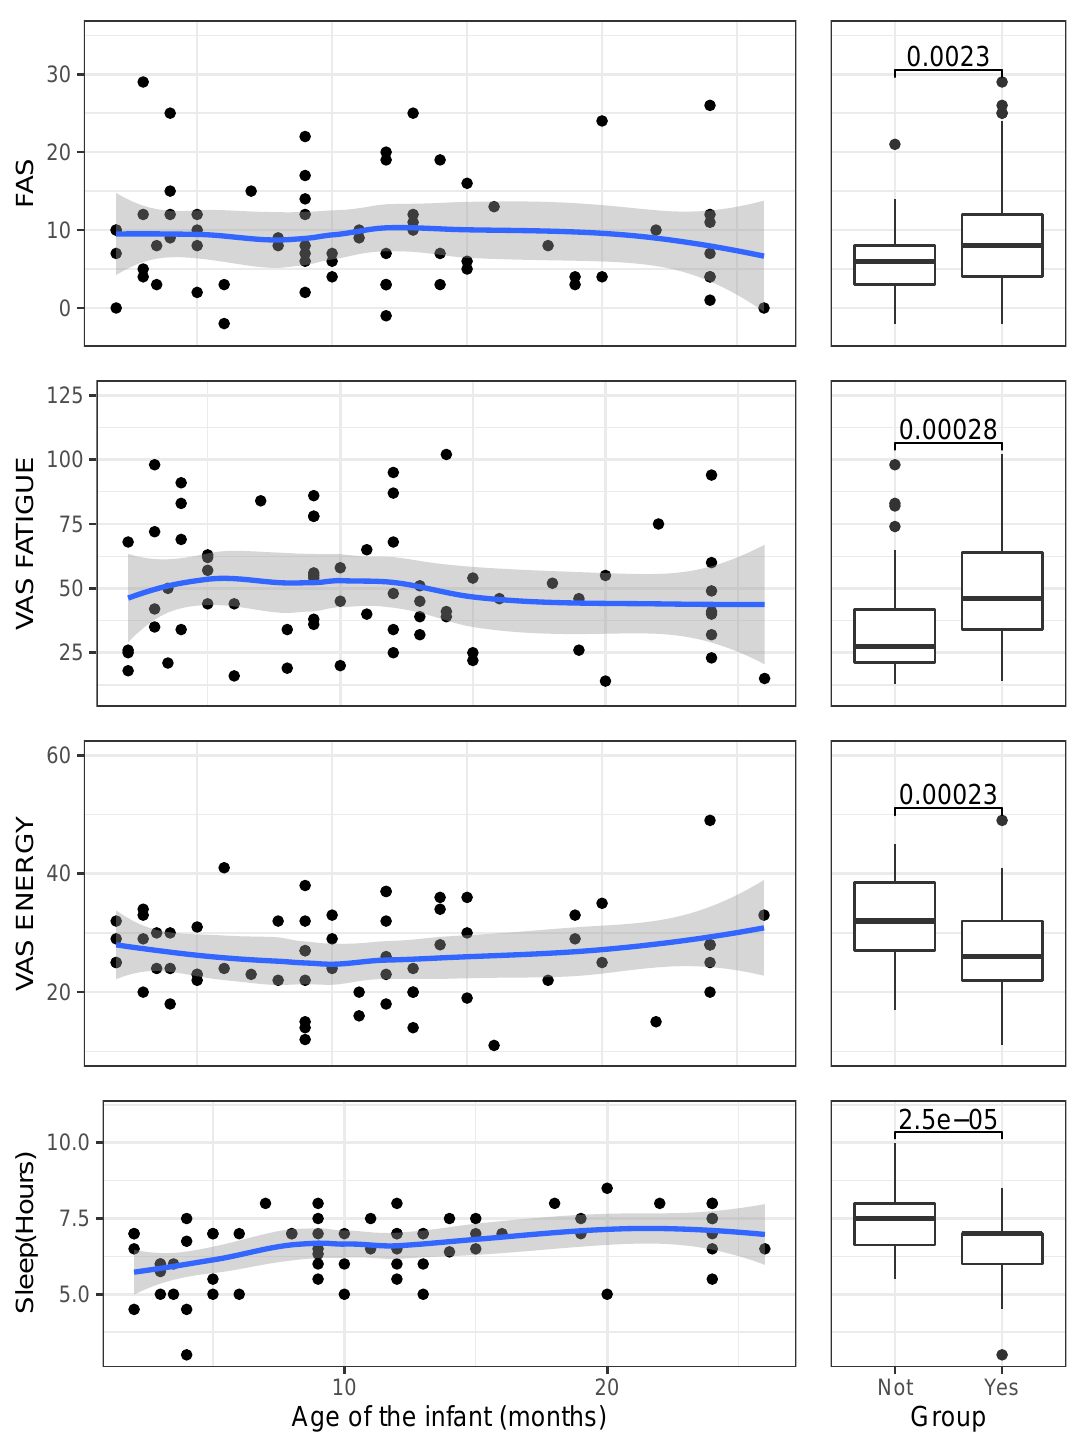
Figure 1. Scatterplots showing the relationship between the age of the infants and the variables of fatigue/hours of sleep of their mothers, and boxplots showing the comparison between the levels of fatigue/hours of sleep of women with or without